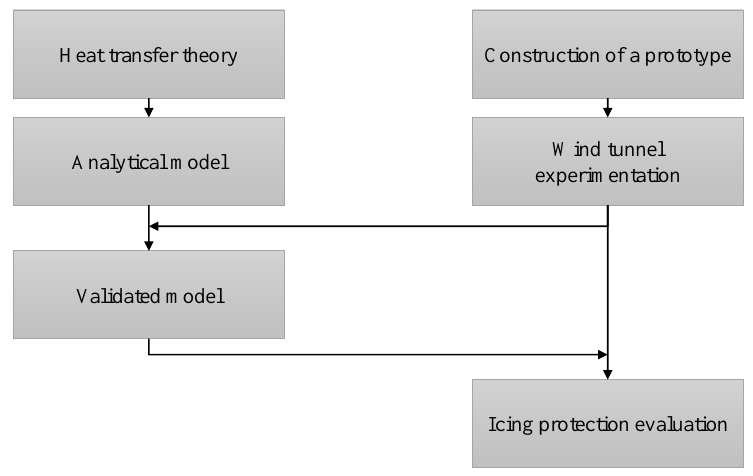
Figure 1. Organisation of the performed